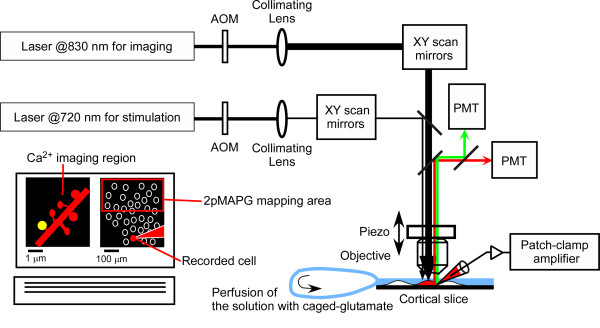
Diagram of the hardware of simultaneous Ca2+ imaging and 2pMAPG mapping. Two mode-locked femtosecond-pulse Ti:sapphire lasers set at 830 nm and 720 nm were connected to the laser-scanning microscope via two independent scanheads. The laser beam illumination times and diameters were regulated by acoustic optical modulators (AOMs) and collimating lens, respectively. A pyramidal cell in the cortical slice was patch-clamped and loaded with Alexa Fluor 594 and Fluo-5F. Extracellular solution containing caged glutamate was oxygenated and re-circulated continuously. On the PC screen, the Ca2+ imaging region (left) and 2pMAPG mapping area (right) were chosen. The imaging plane and mapping plane were changed rapidly by the piezo actuator attached to the objective. AOMs, Galvano mirrors, and the piezo actuator were regulated by FV1000-MPE software. Simultaneously, electric signals from the patch-clamp amplifier and from two photomultiplier tubes for detecting red and green fluorescence were recorded. If a photostimulated neuron innervated one of the spines in the imaging region, Ca2+ transients were observed in this spine (yellow in the PC screen). See the details in the main text.